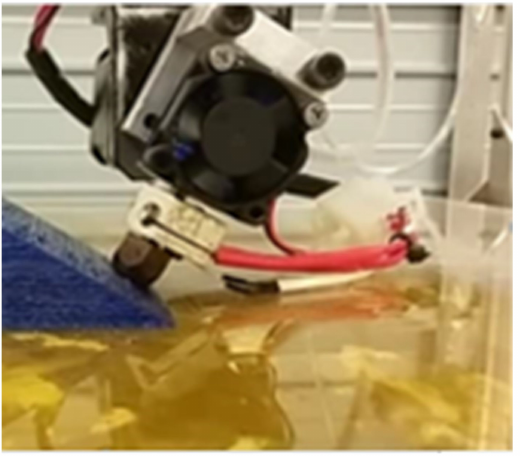
Figure 10. Nozzle rotation for tow placement/consolidation on a 30 ◦ angled tool